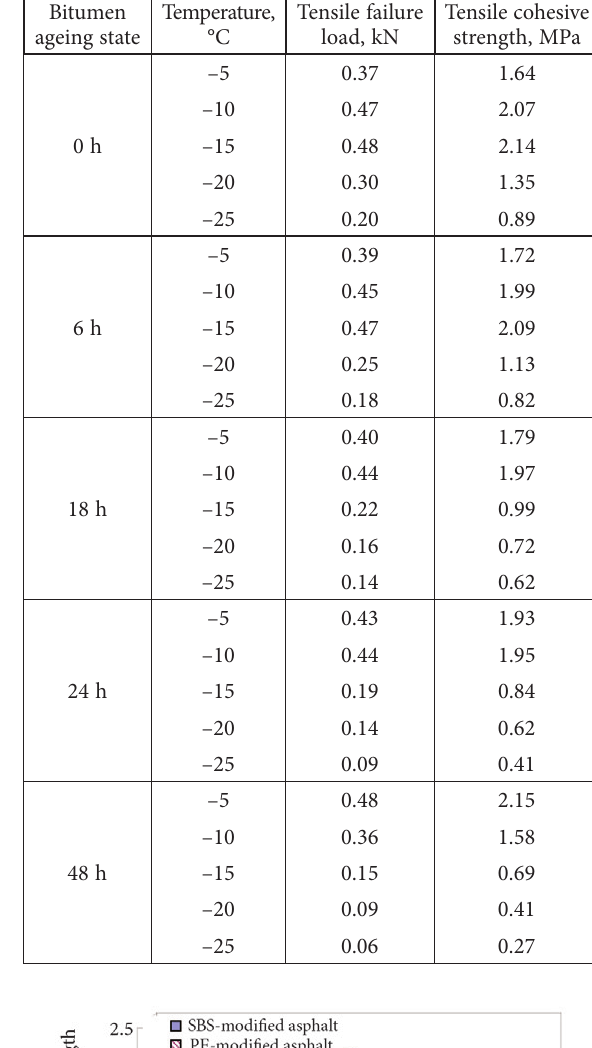
Table 2. Test results of the low-temperature cohesive strength of the SBS-modified bitumen at different ageing states Bitumen Temperature, Tensile failure Tensile cohesive ageing state °C load, kN strength, MPa